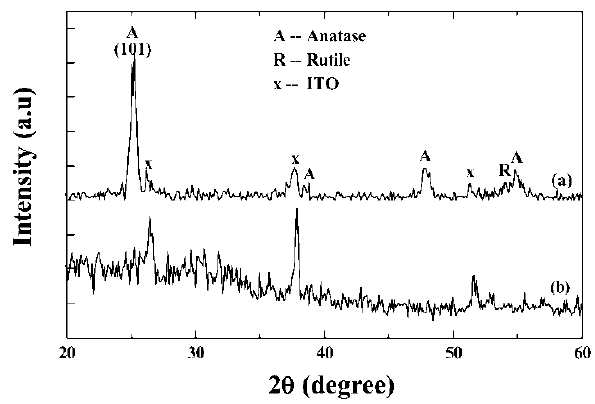
FIGURE 1 XRD spectra of a nanocrystalline TiO 2 thin film (a), and of an ITO-coated glass substrate (b).